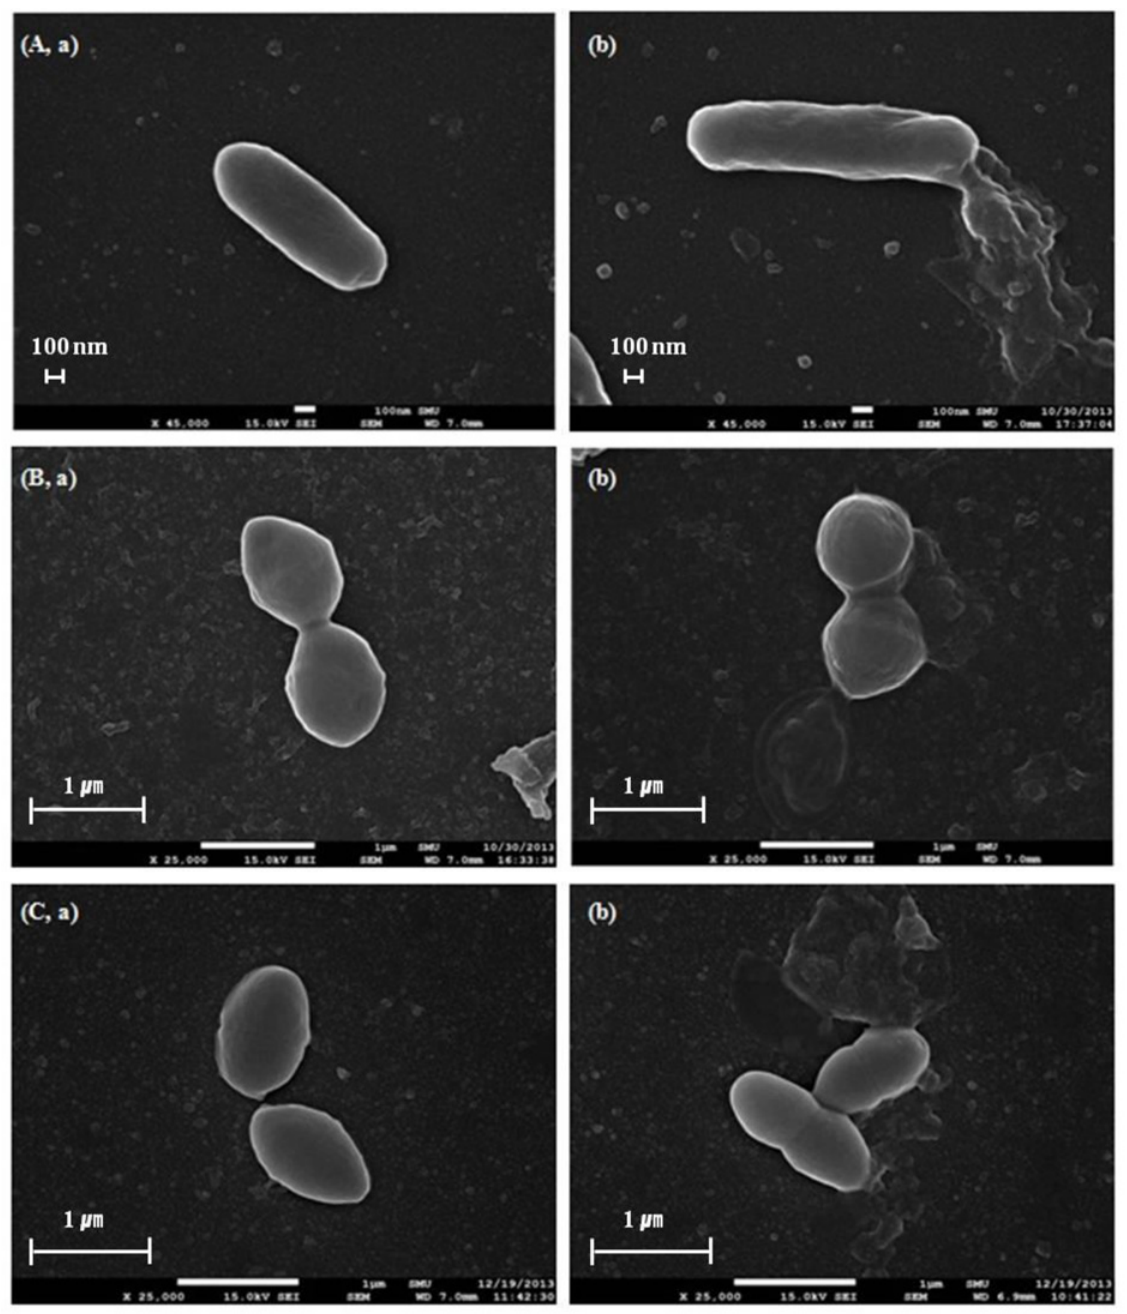
Fig 5. Scanning electron microscope images. After exposed to oleanolic acid at 2 × MIC, untreated (a) and oleanolic acid-treated bacterial cells (b): Listeria monocytogenes (A), Enterococcus faecium (B), and Enterococcus faecalis (C) were examined by SEM.